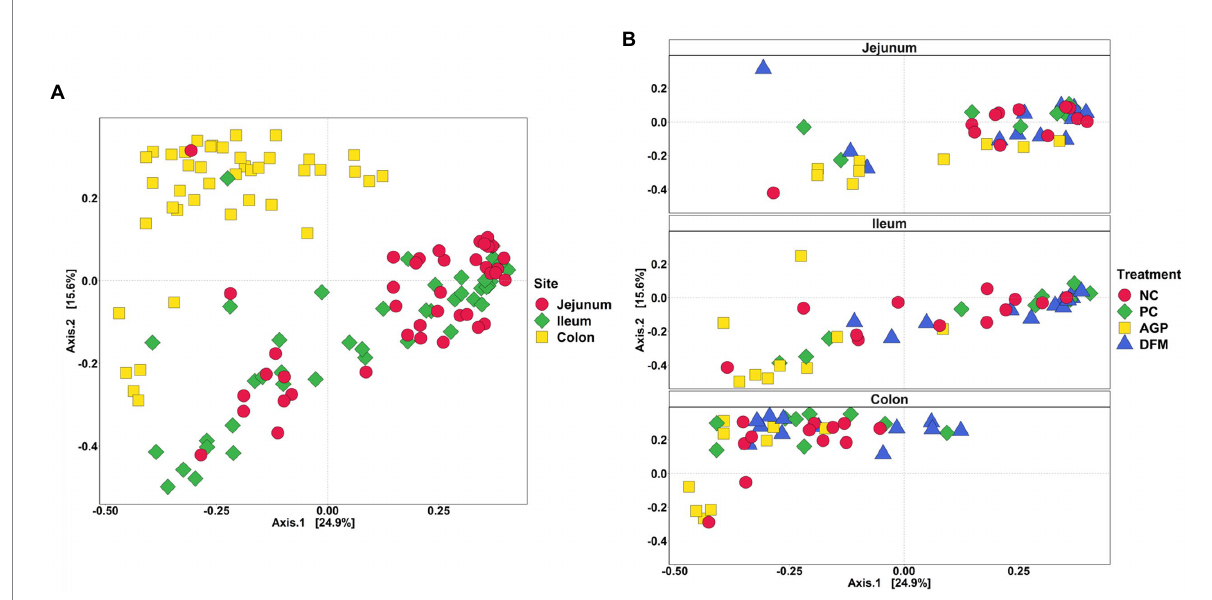
FIGURE 5 Beta diversity of intestinal digesta microbiota in pigs challenged with enterotoxigenic E. coli by intestinal site (A) and treatment (B) . Data were analyzed by principal coordinate analysis (PCoA) based on Bray–Curtis dissimilarity. NC = negative control, PC = positive control, AGP = antibiotics, DFM = B. subtilis . Each mean represents 9–12